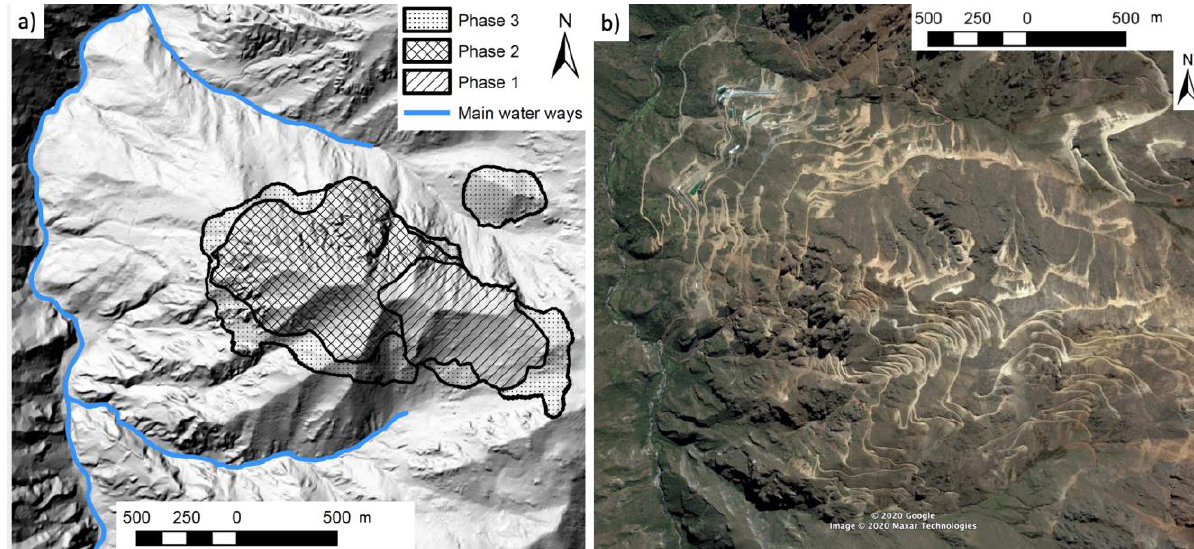
Figure 5. Layout of the three phases of the pit and main waterways ( a ) and aerial view of the same scene ( b ) (© Google Earth, retrieved in 2020, Image © Maxar Technologies 2014).